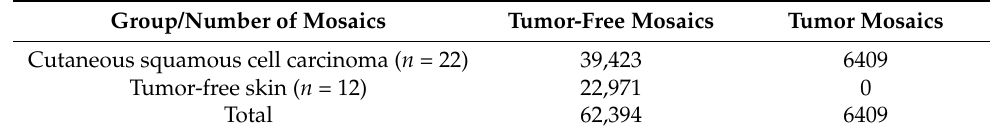
Table 2. Number of mosaics considered ‘tumor-free’ and ‘carcinogenic’. Group/Number of Mosaics Tumor-Free Mosaics Tumor Mosaics Cutaneous squamous cell carcinoma ( n =